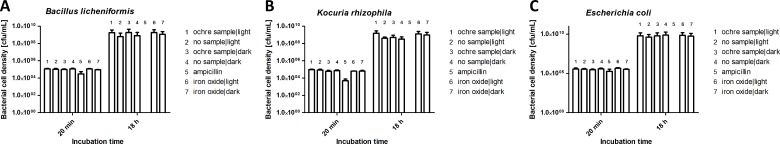
Effect of ochre (soil) (10 mg/mL) and iron oxide (water) (10 mg/mL) on the growth of Bacillus licheniformis (A), Kocuria rhizophila (B) and Escherichia coli (C) after 18 h incubation.The antibiotic ampillicin (32 µg/mL) was used as a positive control.